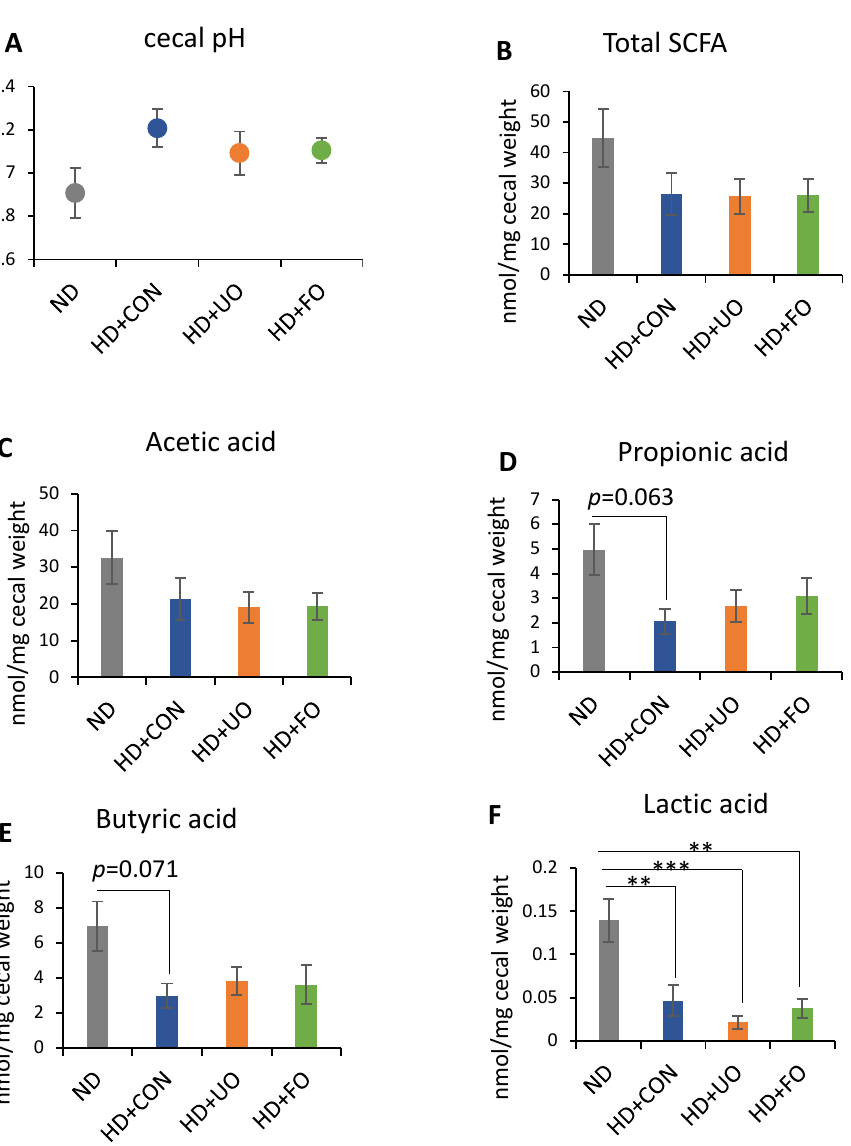
Figure A1. Cecal pH and short chain fatty acid levels. Cecal pH levels ( A ) and the concentration of short chain fatty acid of mice fed each experimental diet for 3 weeks: total SCFA ( B ), acetic acid ( C ), propionic acid ( D ), butyric acid ( E ), and lactic acid ( F ). Data are represented as mean ± SEM (ND, HD + CON, HD + UO: n = 6, HD + FO: n = 7) ** p < 0.01, *** p < 0.001 evaluated using one-way ANOVA with Tukey’s post hoc test.